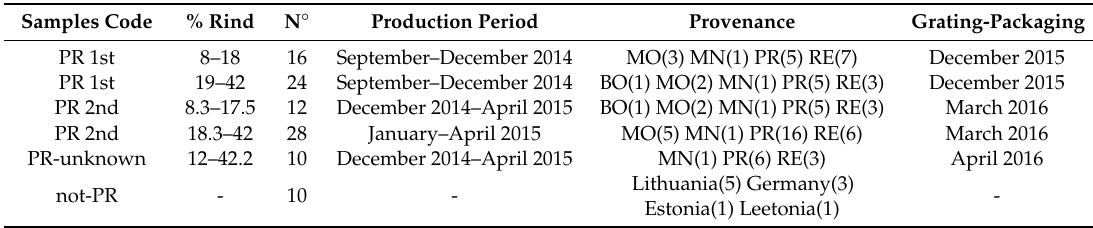
Table 1. Summary information on the analyzed grated cheese